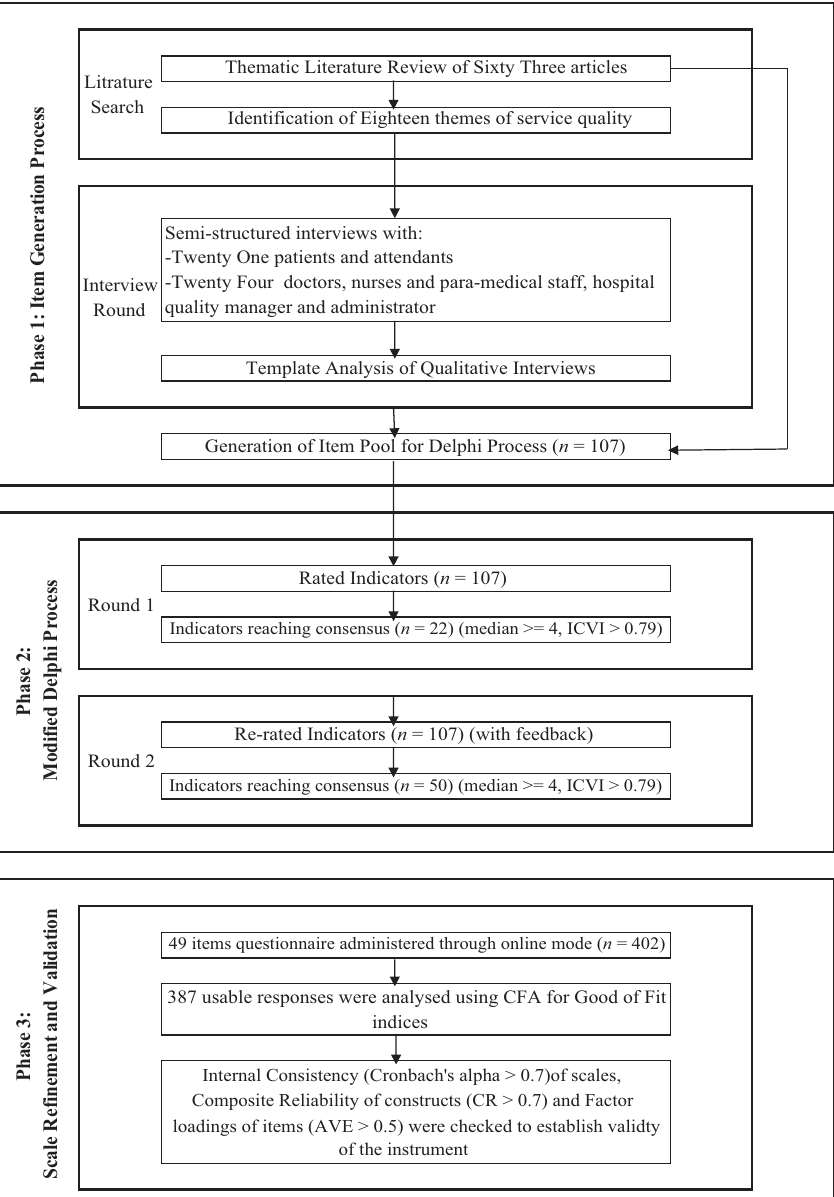
Figure 1. Schema of